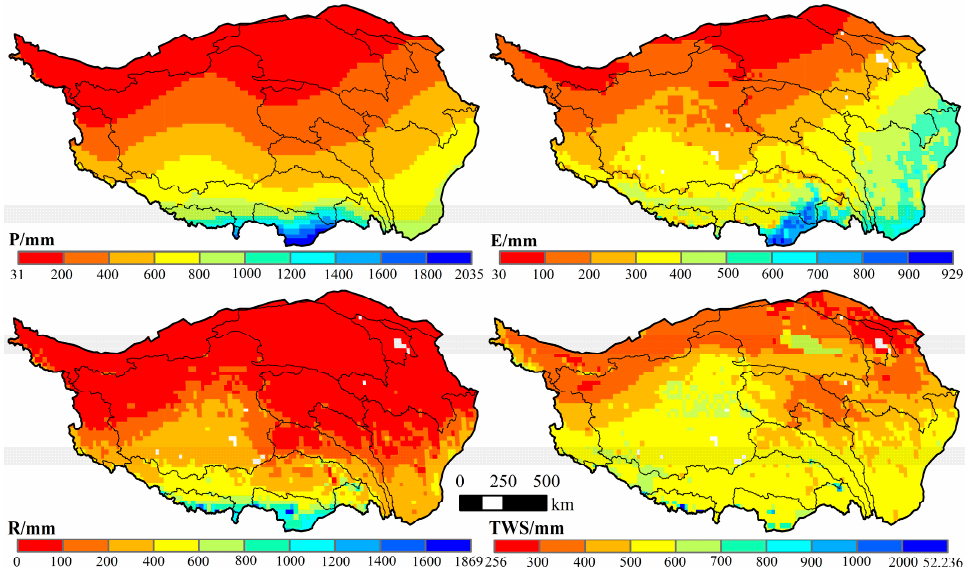
Figure 8. Spatial distributions of hydrological cycle’s elements and terrestrial water storage changes over the Tibetan Plateau.